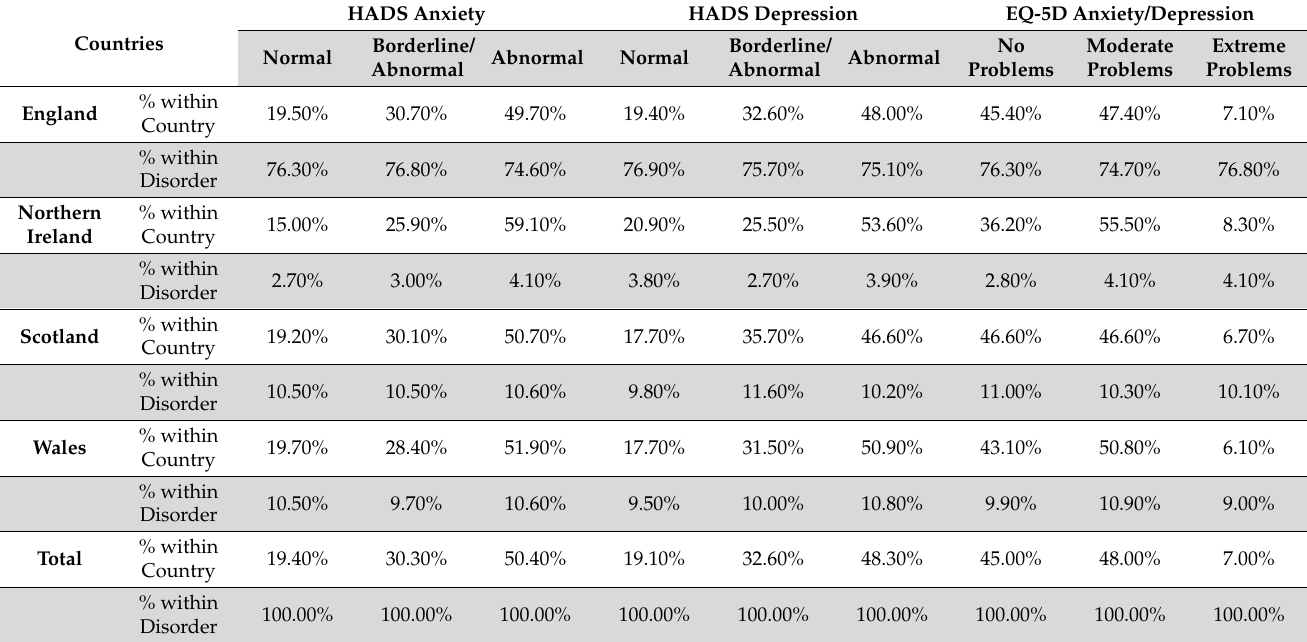
Table 3. Statistics showing anxiety and depression frequencies according to the four countries in the